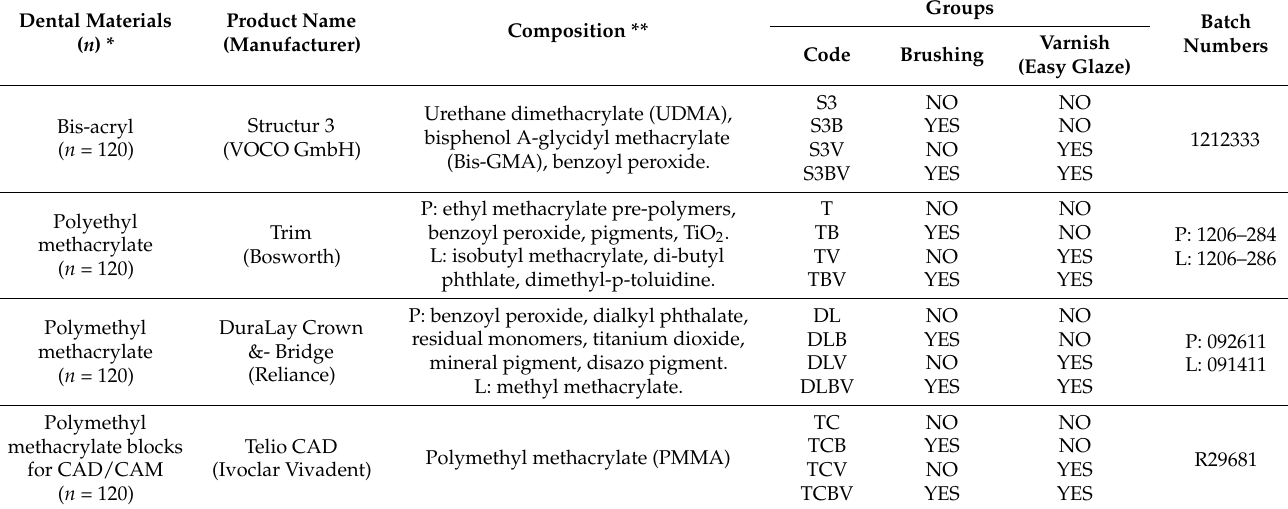
Table 1. Provisional materials used in the